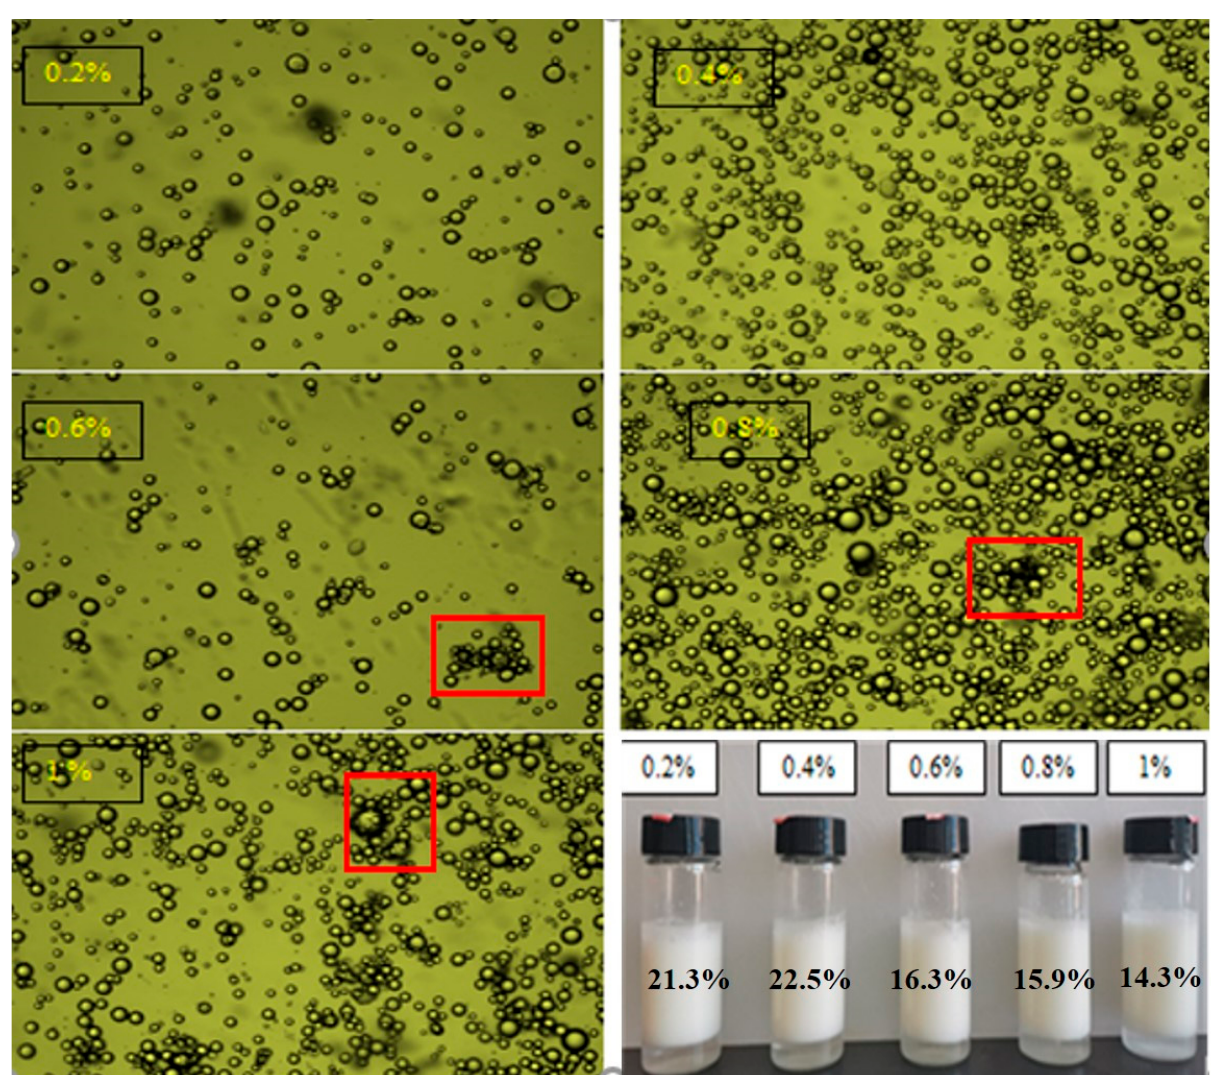
Figure 6. Microscopic image and macro view of double-layer emulsion. The graphs were collected at 100 × magnification. (The red boxes point out that the emulsion drops gathered together. The creaming indexes of double-layer emulsions are labeled in the picture.).